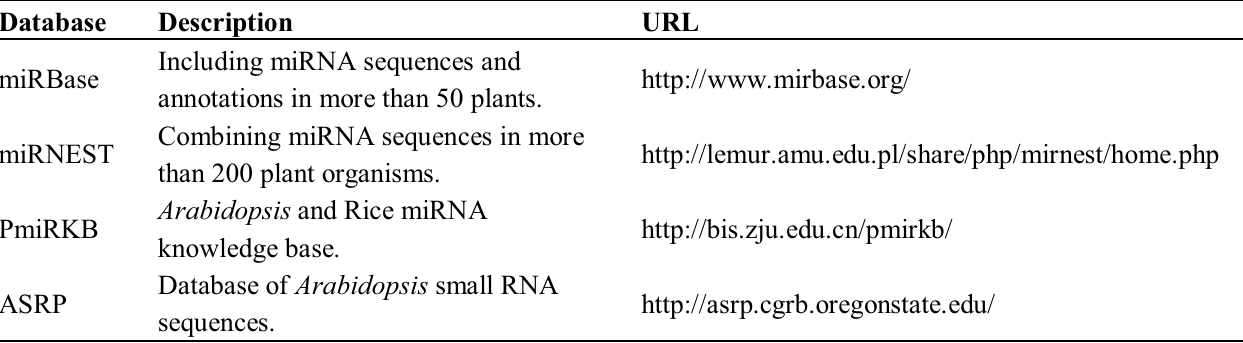
Table 2. Databases for plant miRNAs with integrated deep sequencing